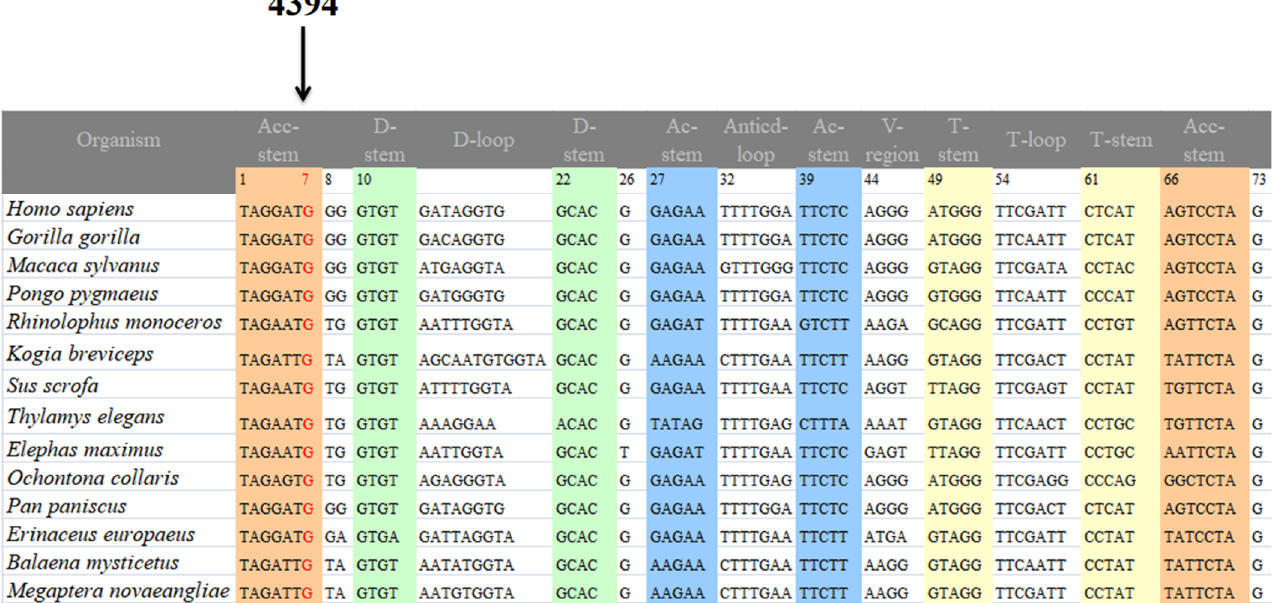
Figure 6. The cellular morphology of human ρ° and cybrids cells.